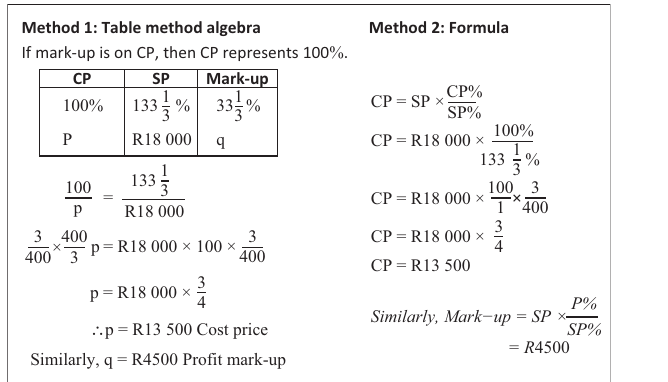
FIGURE 11: Cost of sales calculation given a mixed fraction percentage.